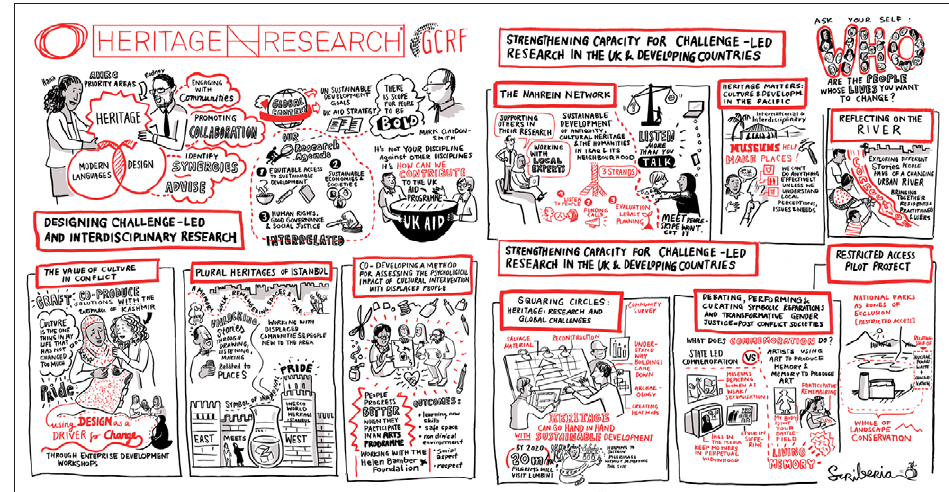
Figure 2: Visual summary of the Heritage and Global Challenges Workshop, organised by the AHRC Heritage Priority Area Team and held at the British Academy on 6 th October 2017. Illustration produced by Somang Lee for